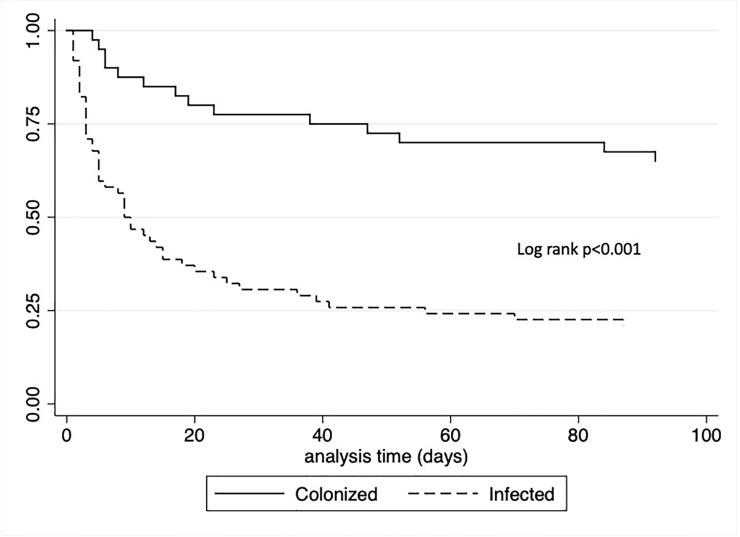
Kaplan Meier survival in 106 patients with A. baumannii divided by colonized (n = 40) or infected (n = 66).